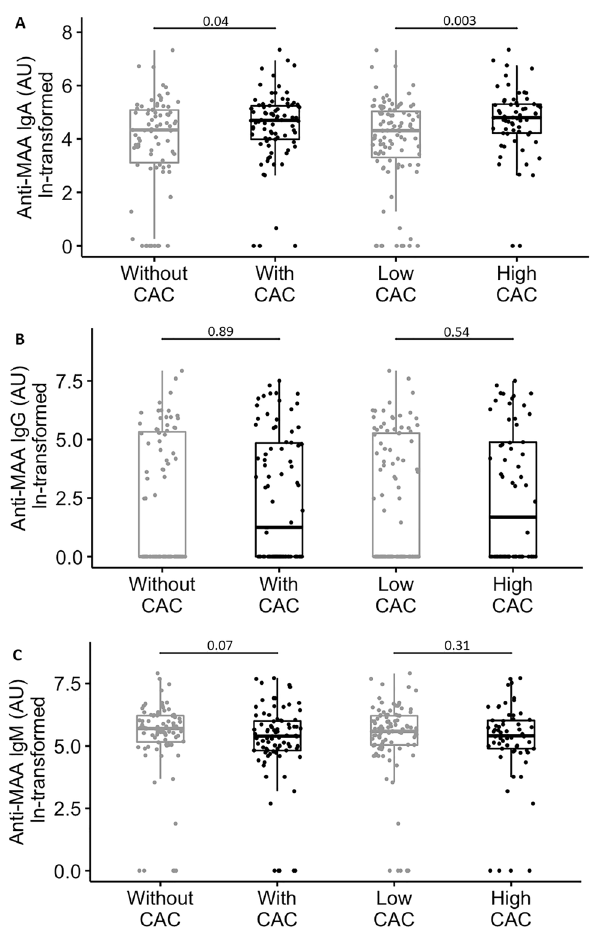
Figure 1. Plots of anti-MAA antibody isotype concentrations based on coronary artery calcium in patients with rheumatoid arthritis. Box demonstrates the median, upper and lower quartiles. Whiskers represent 95% confidence intervals. CAC = coronary artery calcium. High CAC = high coronary artery calcium score based on ≥ 300 Agatston units or ≥ 75th percentile for age, sex, and ethnicity. AU = arbitrary units. Serum anti-MAA IgA concentrations were significantly higher among those with CAC compared to those without CAC (Panel A, P = 0.04), and significantly higher among those with high CAC compared to low CAC (Panel A, P = 0.003). Anti-MAA IgG and IgM serum concentrations were not significantly altered based on CAC (Panels B and C, all P >